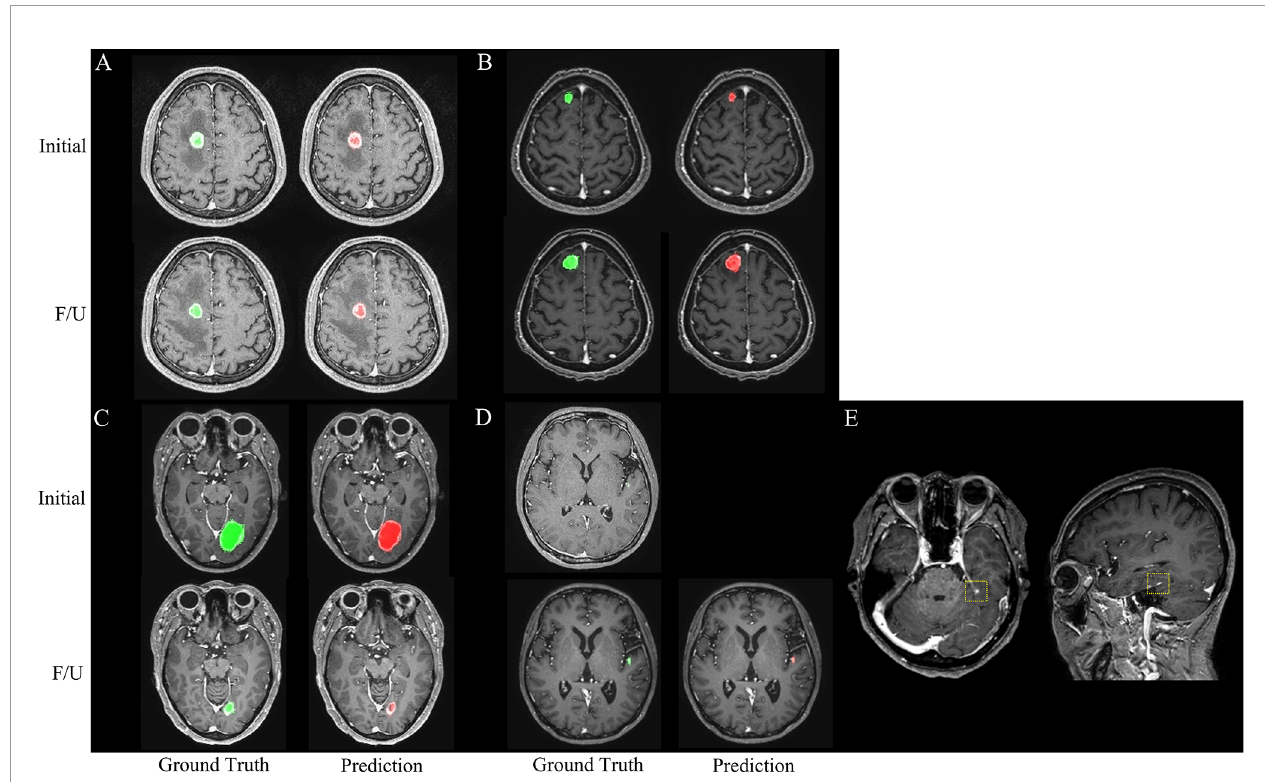
FIGURE 4 | Representative cases (A – E) for automated brain metastasis (BM) detection, segmentation, and treatment response assessment using our proposed deep learning computer-aided detection (DL-CAD) system. (A) Stable disease. (B) Progressive disease. (C) Partial response. (D) False-negative detection of a small BM in the left temporal lobe on initial MRI, which showed enlargement and was correctly detected on a follow-up MRI. (E) False-positive detection. A small cortical vein was falsely detected by DL-CAD (dotted square), which could be easily differentiated by